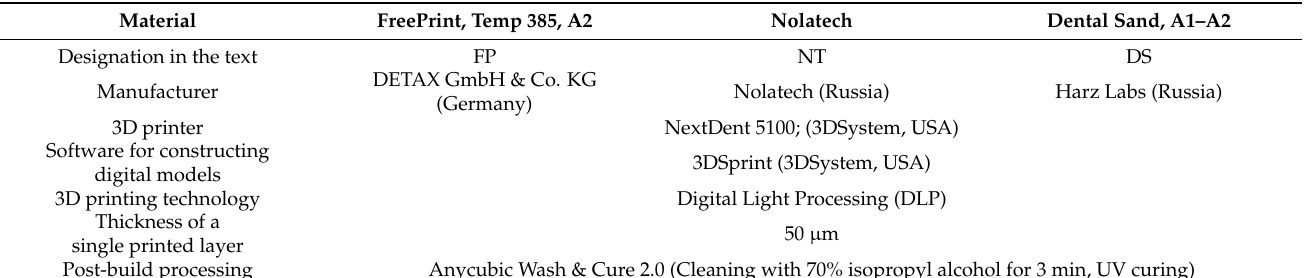
Table 1. The data on the 3D printing materials and